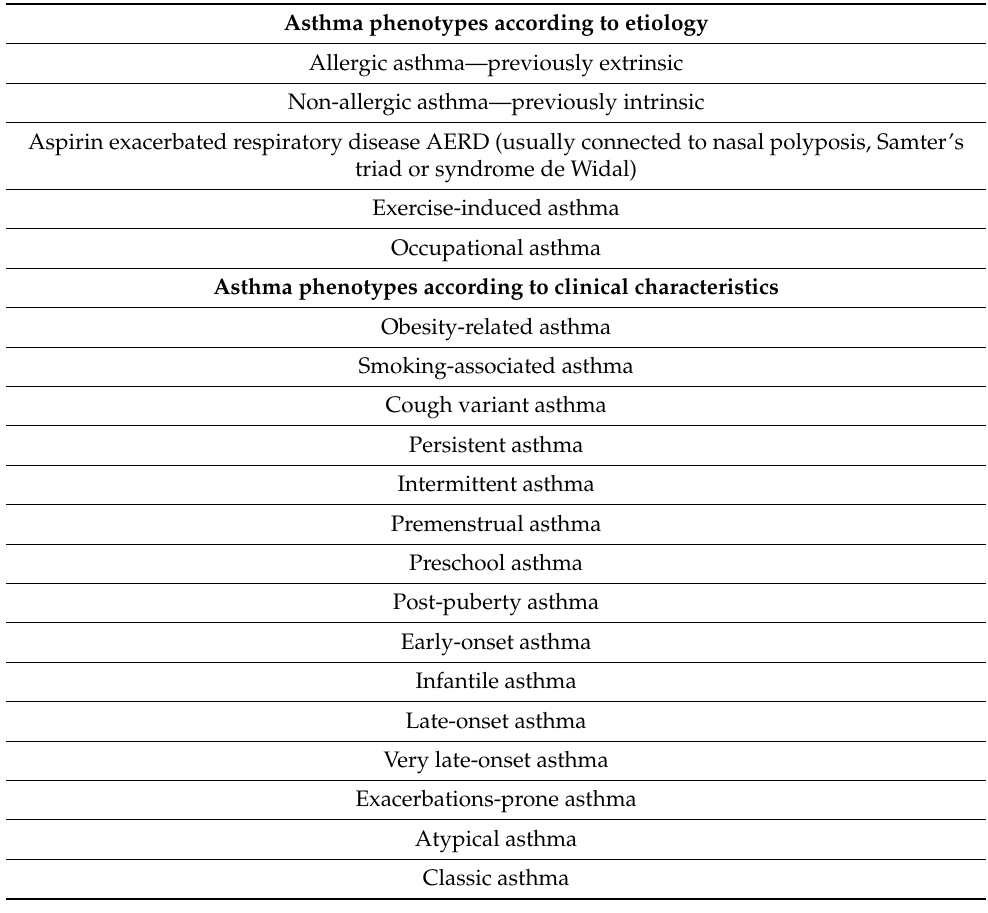
Table 1. Asthma phenotyping—evolution and modern